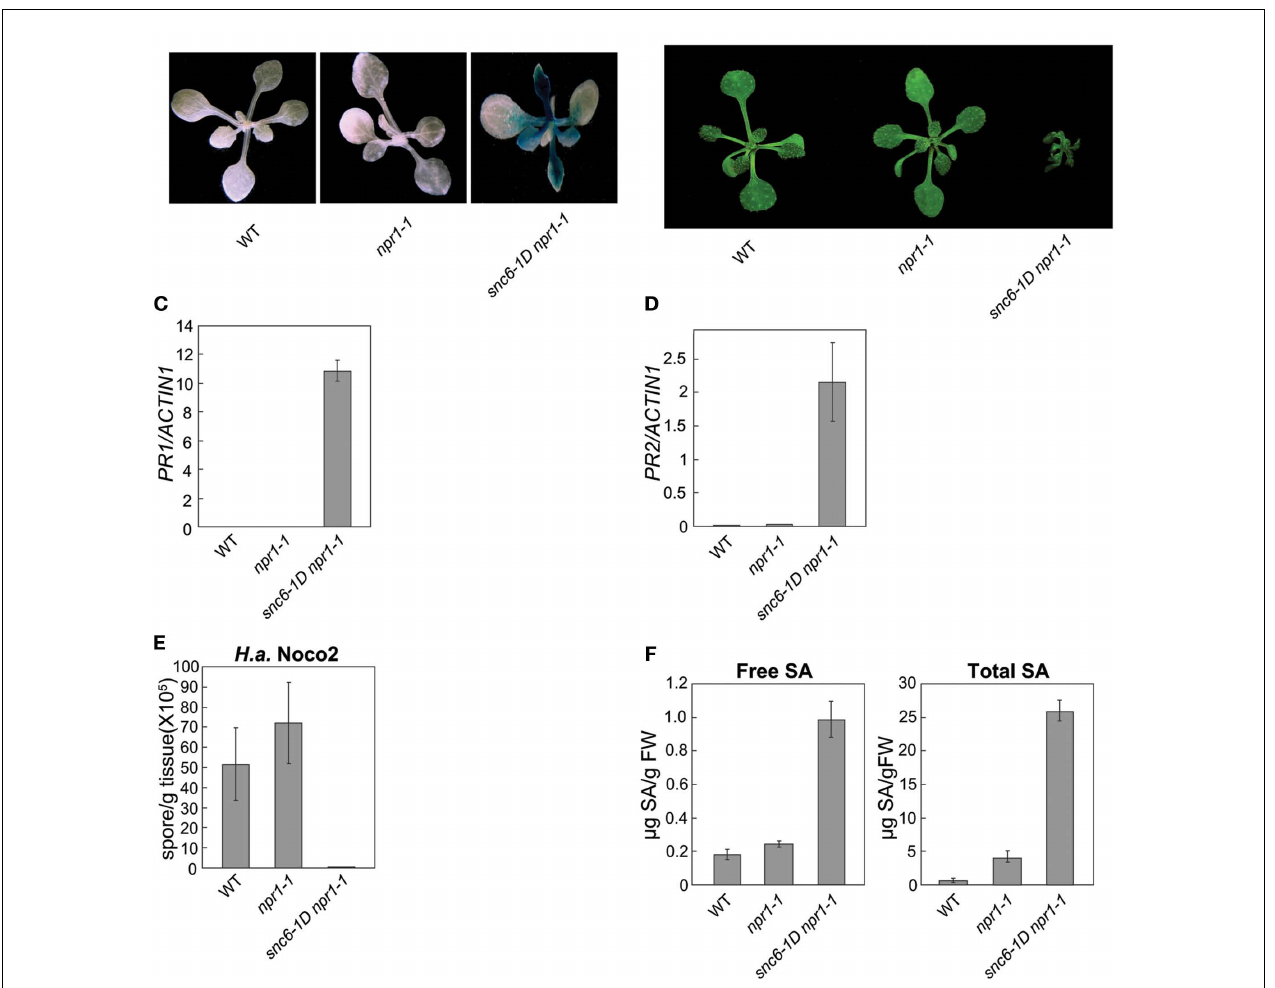
photographed. (C,D) Endogenous expression of (C) PR1 and (D) PR2 relative to Actin 1 inWT, npr1-1 , and snc6-1D npr1-1 .Values presented are averages of three replicates ± SD. (E) Growth of H.a. Noco2 onWT, npr1-1 , and snc6-1D npr1-1 mutants 7days post-infection.Values presented are averages of three replicates ± SD. (F) Endogenous free and total SA levels inWT, npr1-1 , and snc6-1D npr1-1 . Plants were grown on soil for 4weeks and leaf tissue was collected for SA extraction. SA levels were analyzed using high-pressure liquid chromatography.Values presented are averages of four replicates ±